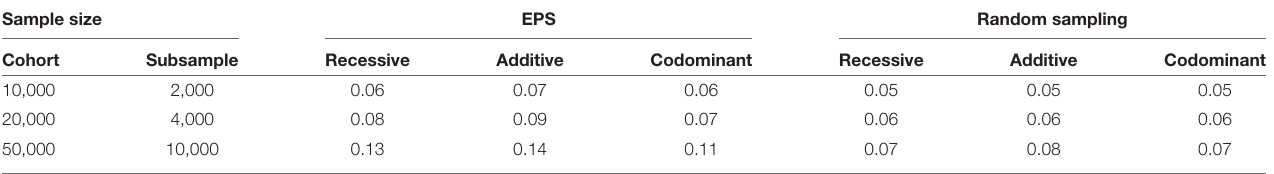
TABLE 3 | Effect of false positive rate due to confounding when sample size is increased. Sample size